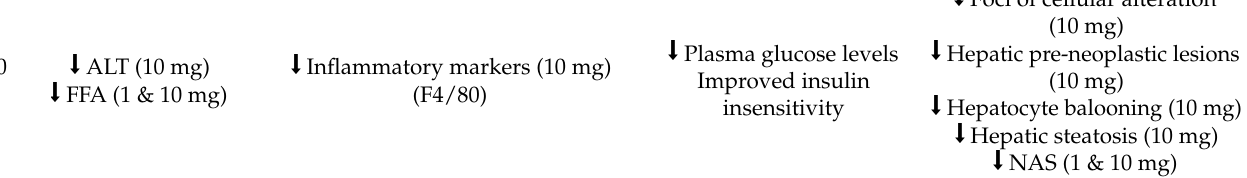
Table 1. Key animal studies regarding the impact of empagliflozin on NAFLD/NASH.